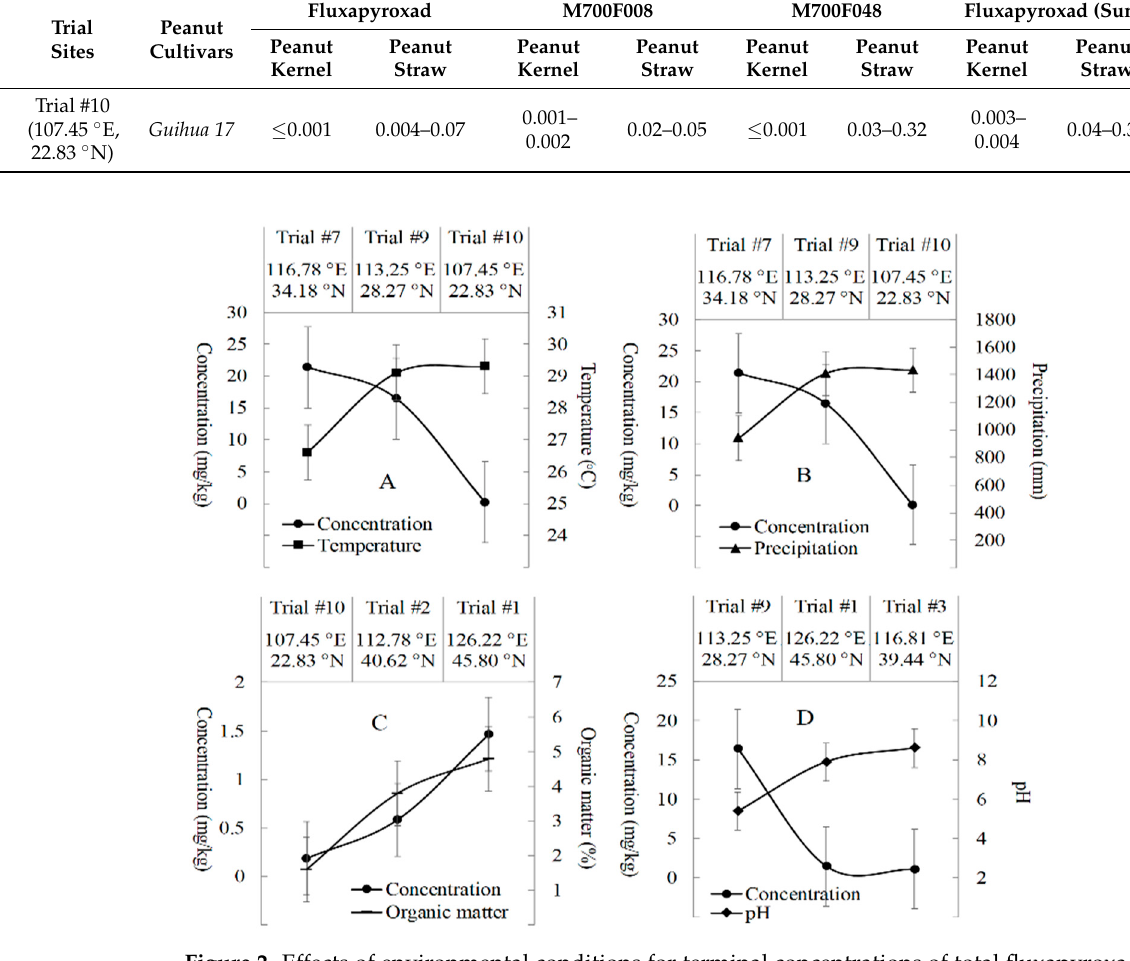
Figure 2. Effects of environmental conditions for terminal concentrations of total fluxapyroxad in different trial sites of peanut crops. ( A ) Temperature was negatively correlated with concentration of fluxapyroxad; ( B ) Precipitation was negatively correlated with concentration of fluxapyroxad; ( C ) Organic matter content was positively correlated with concentration of fluxapyroxad; ( D ) pH was negatively correlated with concentration of fluxapyroxad. Table 2. Concentrations of fluxapyroxad and metabolites in peanut samples at 14–21d after appli- cation.